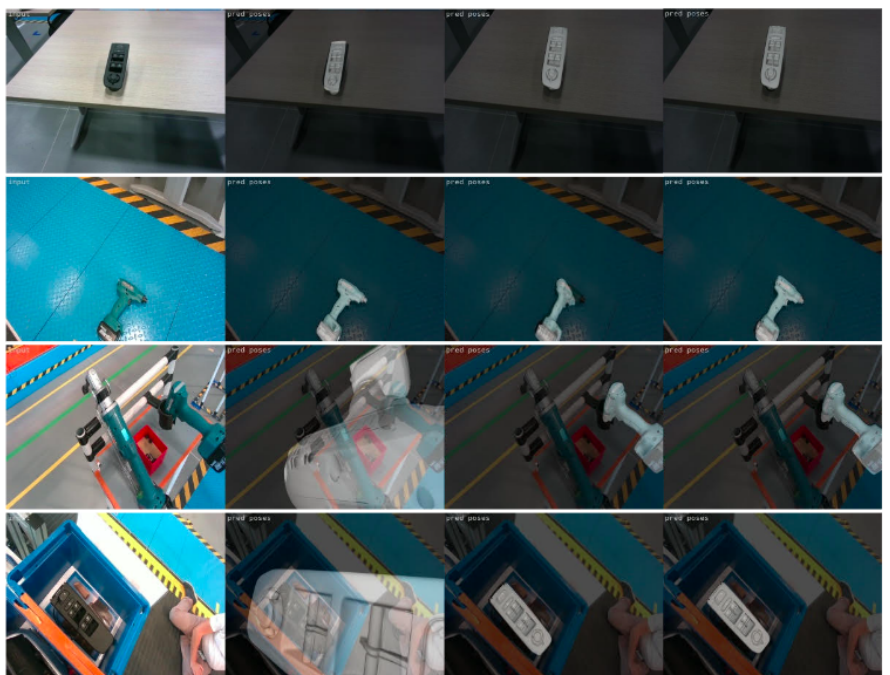
Figure 22. Comparison of the results of the three trained models. The first column shows the input RGB image. The rest show the results for the models trained on only laboratory, only real environment, and both laboratory and real environment data,